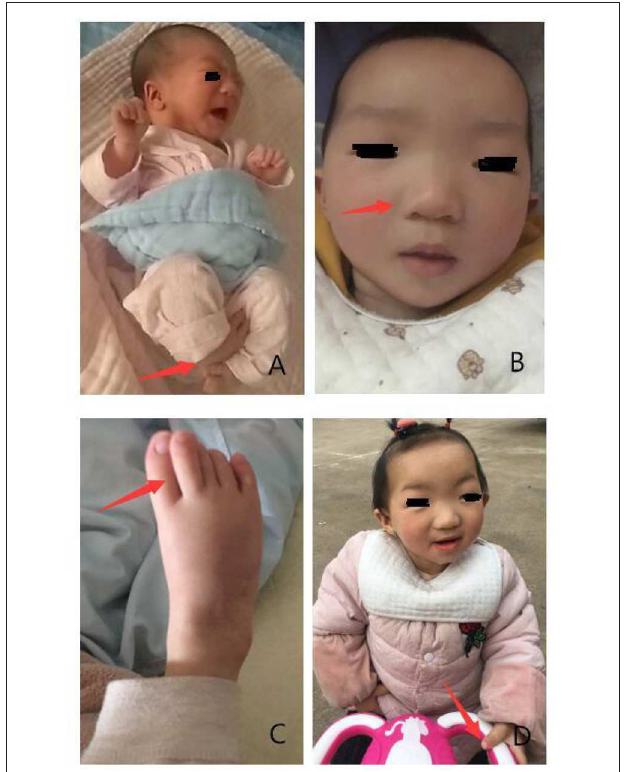
FIGURE 1 | Phenotypes presented in the patient with KAT6B genetic variant. (A) Congenital horseshoe varus foot at birth. (B,C) Narrow palpebral fissure, ptosis, a broad nasal bridge, bulbous nasal tip, small mouth, thin upper lip, great toes. (D) Stand up with assistance when she was 19